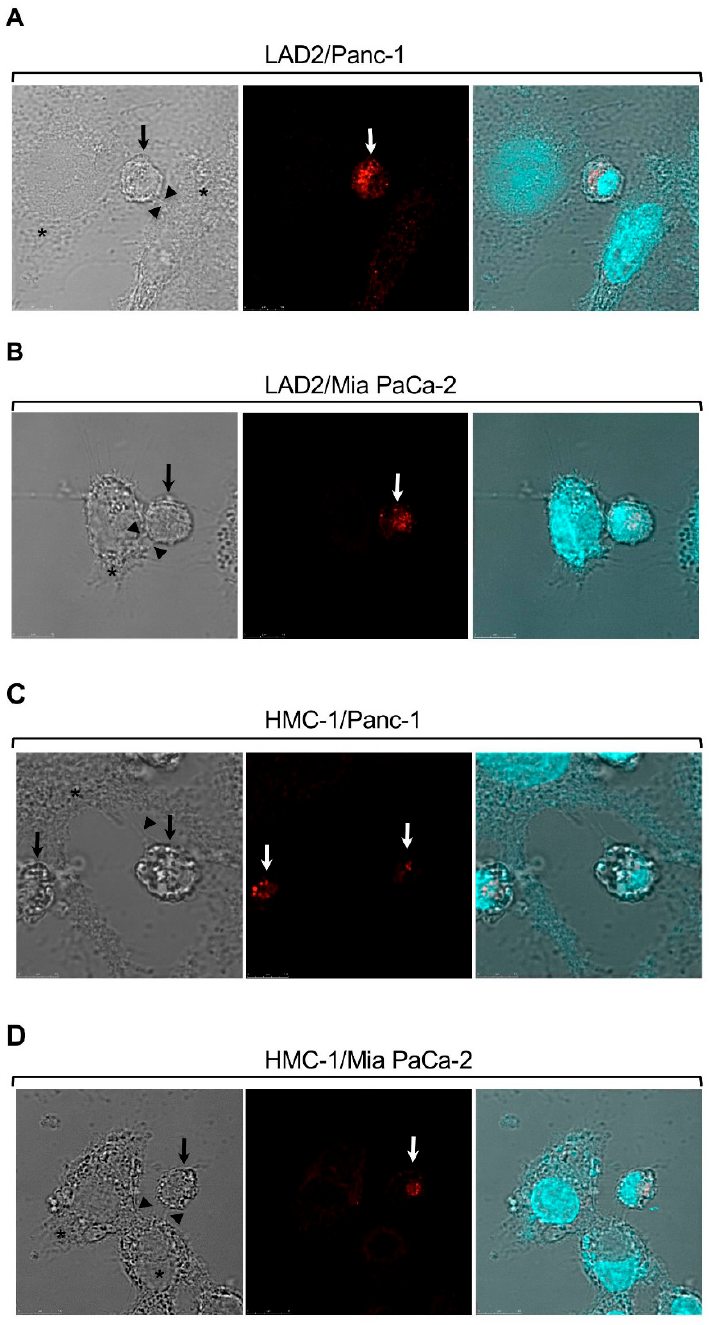
Figure 1. Mast cells (MCs) form synapses with pancreatic cancer cells in co-culture. LAD2 ( A , B ) or HMC-1 cells ( C , D ) were co-cultured with Panc-1 ( A , C ) or Mia PaCa-2 ( B , D ) cells at 1:1 ratio. MCs were stained with antibodies directed against tryptase and visualized by confocal microscopy. Bar = 10 µ m. Arrows point to MCs, stained in red. Asterisks mark pancreatic cancer cells and arrowheads point to contact areas formed between the MCs and the pancreatic cancer cells. “Reprinted from Cancer Letters, 397, Yaara Gorzalczany, Eyal Akiva, Ofir Klein, Ofer Merimsky and Ronit Sagi-Eisenberg, Mast cells are directly activated by contact with cancer cells by a mechanism involving the autocrine formation of adenosine and autocrine / paracrine signaling of the adenosine A3 receptor. 23-32. Copyright © 2017 with permission from